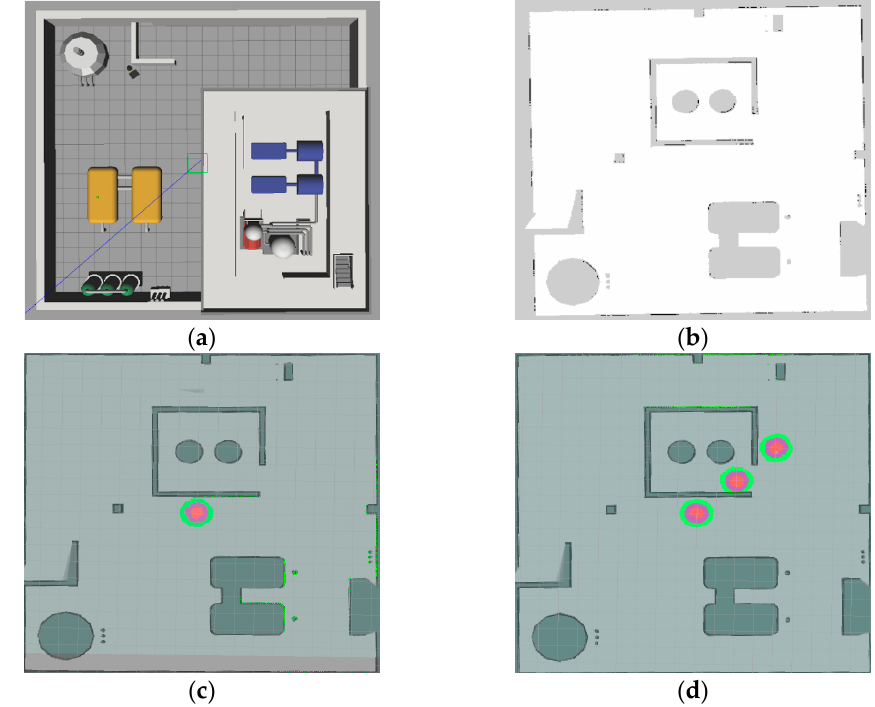
Figure 10. Map fusion results: ( a ) simulation environment, ( b ) grid map of the simulated